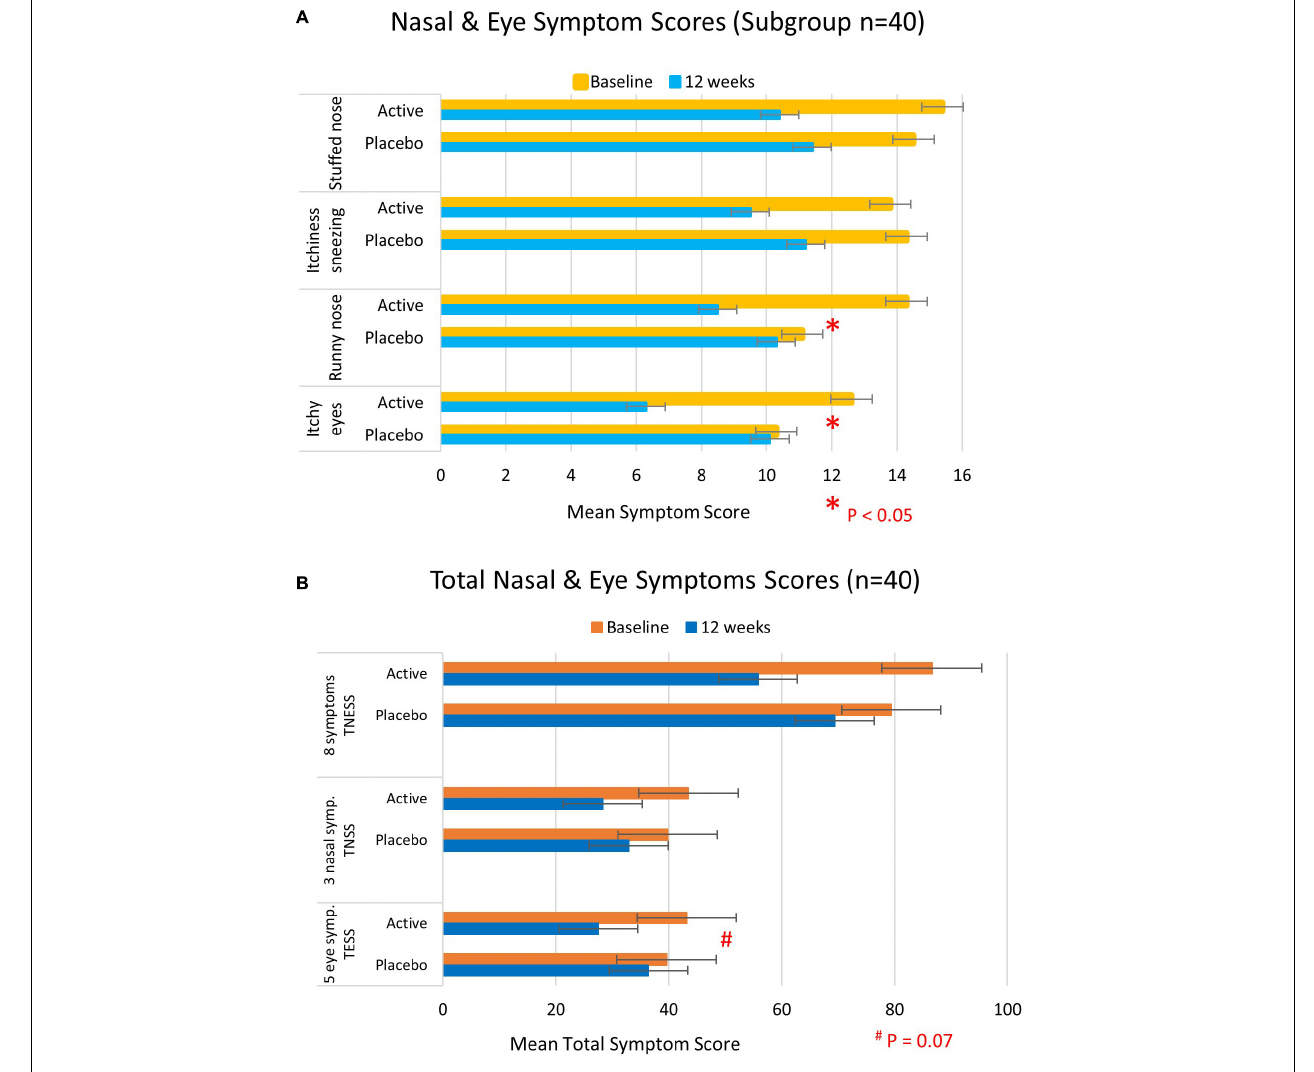
FIGURE 3 | Total nasal and eye symptom scores at baseline (yellow/orange bars) and 12 weeks (blue bars) of participants who took the full course of 10–12 week trial intervention ( n = 40). (A) Individual symptom scores and (B) total nasal and/or eye symptom scores. Higher scores represent more severe symptoms.